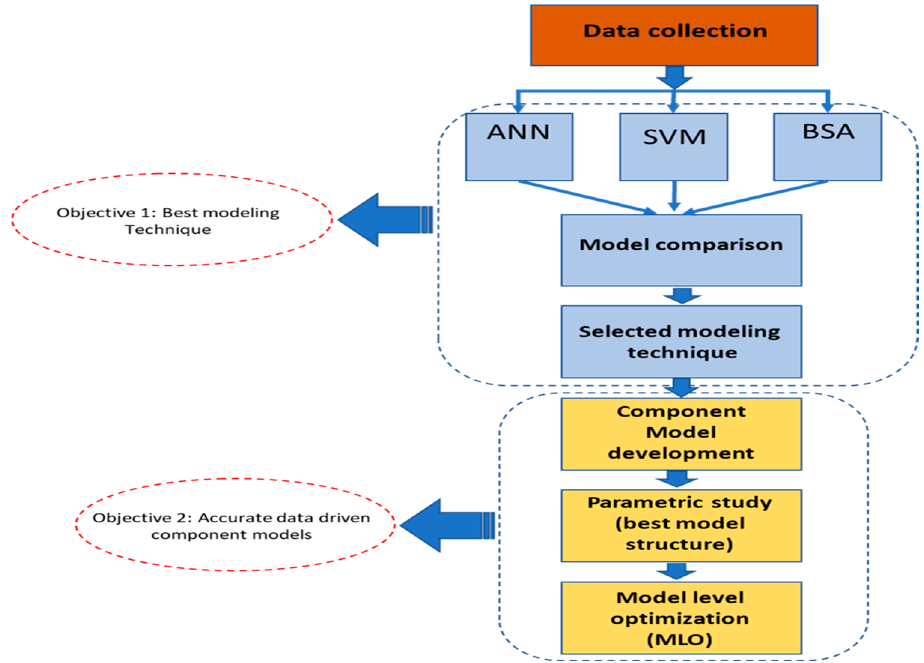
Figure 1. A schematic of the modeling strategy.